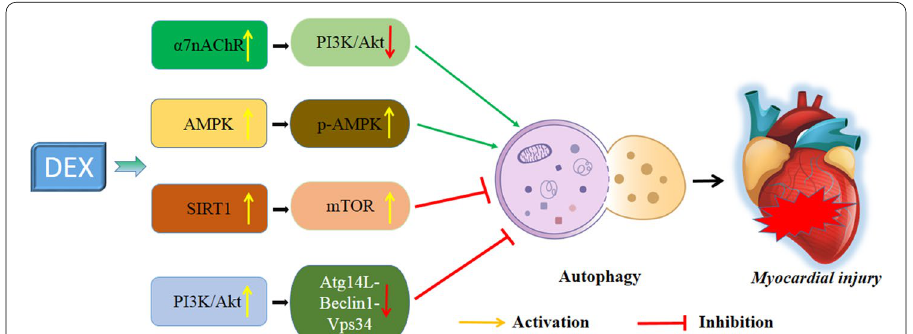
Fig. 2 Mechanisms of autophagy in myocardial-protective effects of DEX. 7nAChR α7 nicotinic acetylcholine receptor, SIRT1 Sirtuin 1, AMPK adenosine monophosphate-activated protein kinase, VPS34 vacuolar protein sorting